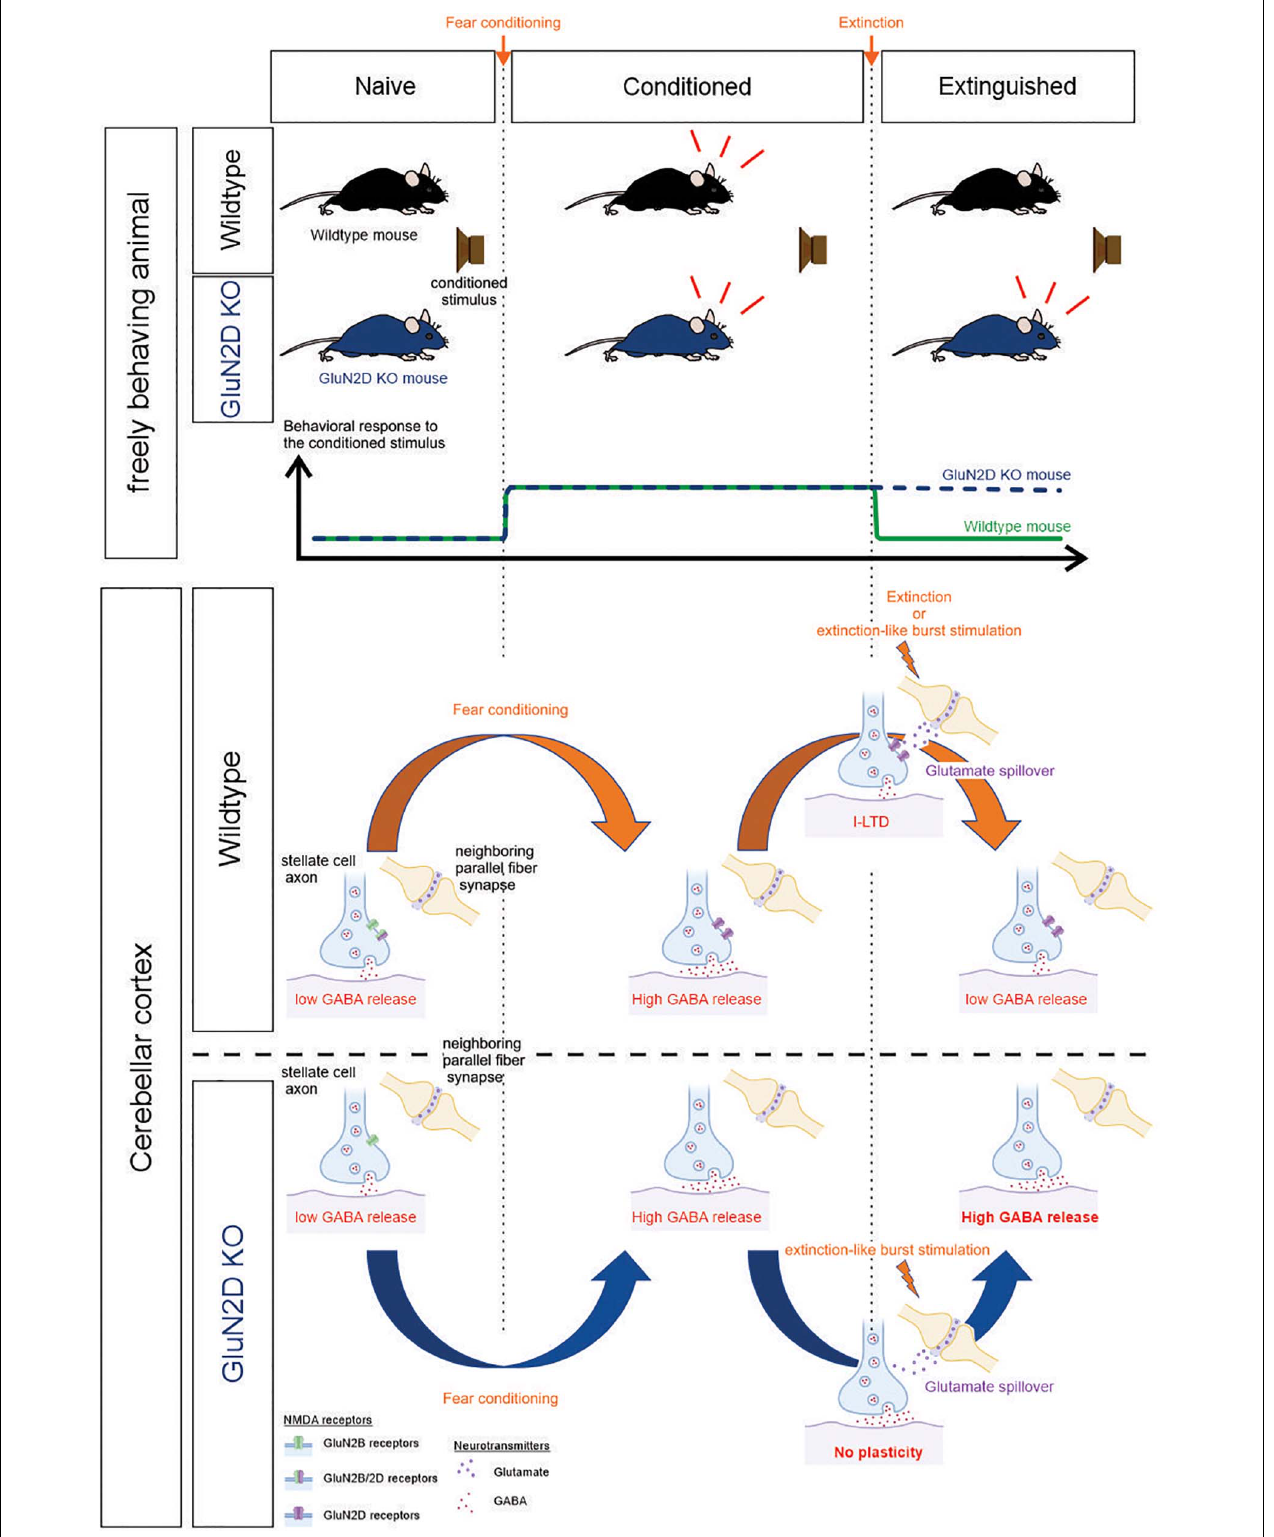
FIGURE 7 | Summary schematic. Top , the behavioral response of wildtype and GluN2D KO mice during fear conditioning and extinction training. Bottom , correlated cellular events at the stellate-to-stellate cell synapse in the cerebellar cortex. The bottom part of the schematic was created with biorender.com.